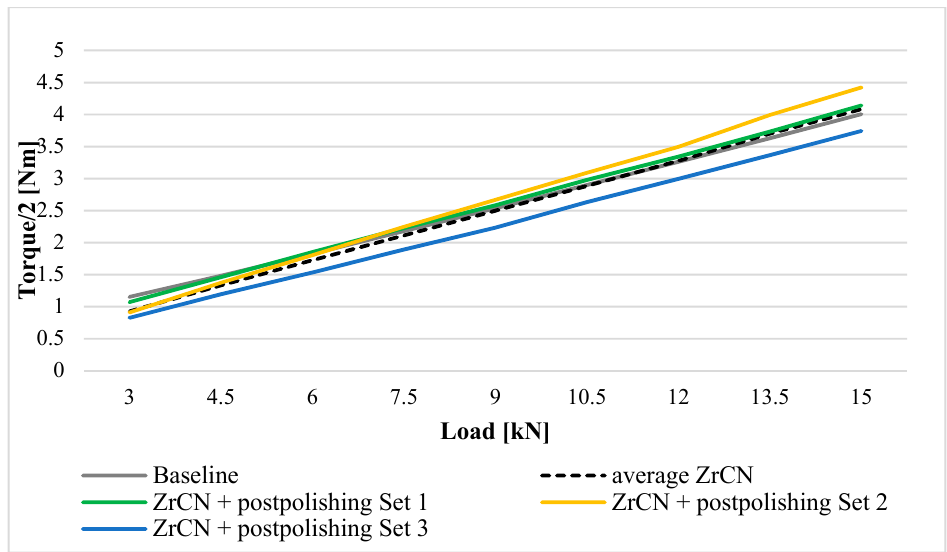
Figure 17. 594A/592A ZrCN + polish post-processing TTR friction test vs Baseline. Figure 17. 594A / 592A ZrCN + polish post-processing TTR friction test vs